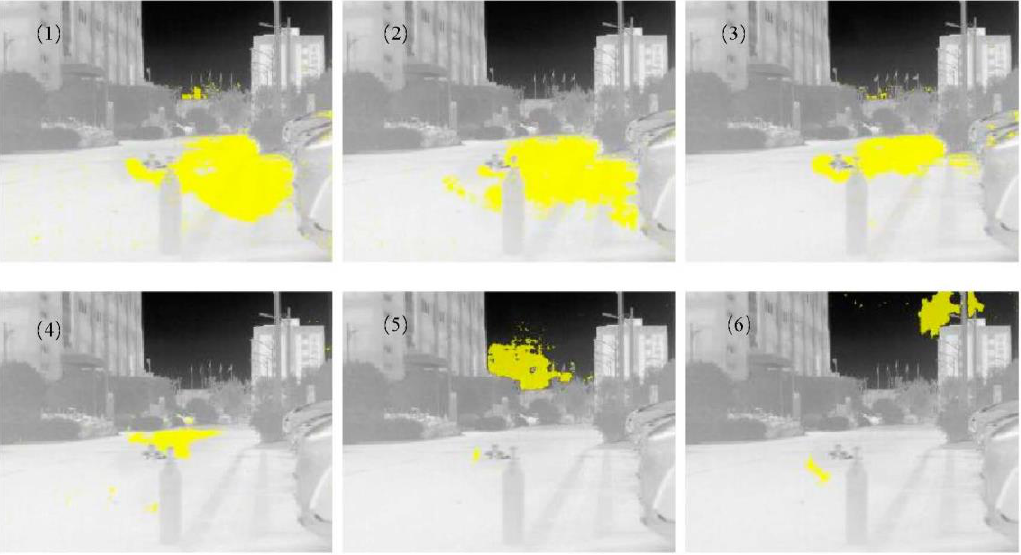
Figure 8. SF6 release experiment and classification results colored in yellow. Each picture is taken 8 s intervals.